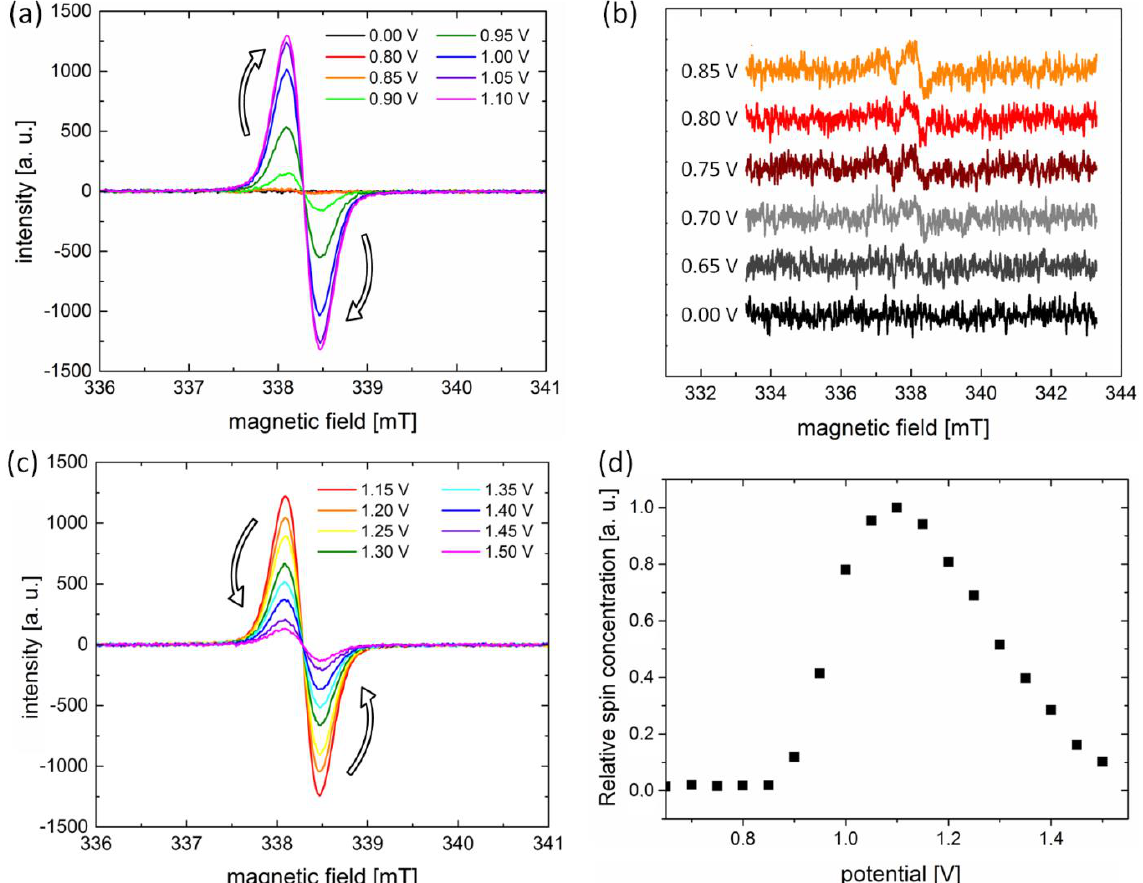
Figure 5. EPR spectroelectrochemistry of the H5T radical cation generated during electrochemical oxidation. ( a ) EPR spectra collected with increasing applied potential. EPR signal appears at 0.90 V and continues to grow for potentials up to 1.10 V. ( b ) Detailed EPR spectra collected in the 0.65 – 0.85 V range. ( c ) Decrease in EPR signal for 1.15 – 1.50 V applied potential. ( d ) Changes in the relative concentration of spins generated during oxidation. The sample consisted of 1 × 10 − 3 mol dm − 3 H5T solution in dichloromethane with 0.2 mol dm − 3 of Bu 4 NBF 4 as the supporting electrolyte.